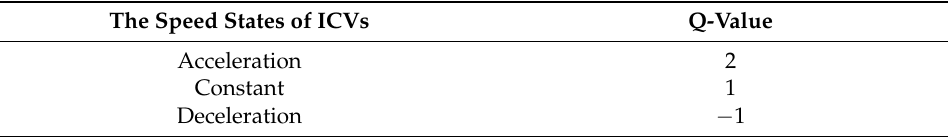
Table 2. The configurations list of Q-values according to ICV states. The Speed States of